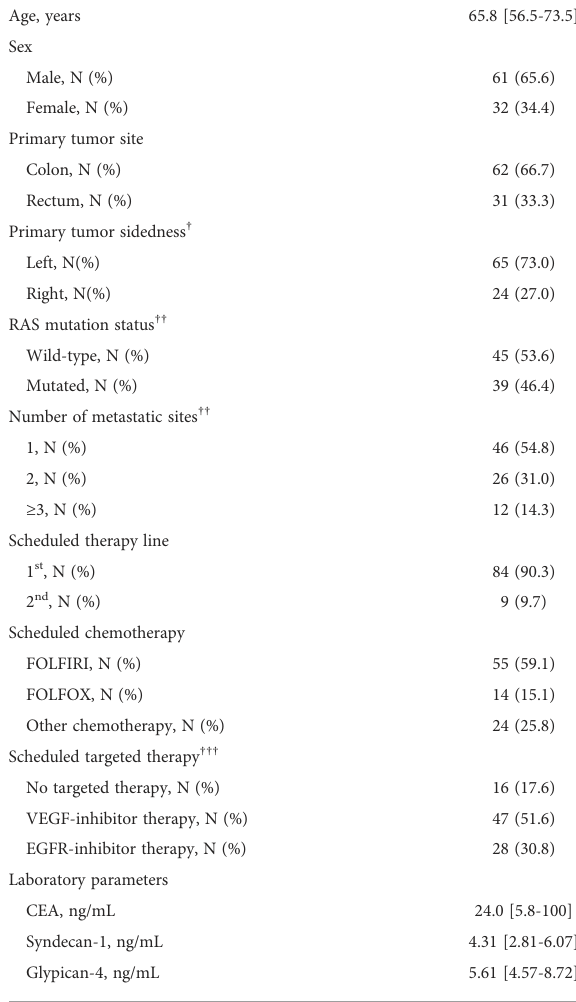
TABLE 1 Basic clinical and clinicopathological characteristics of the total